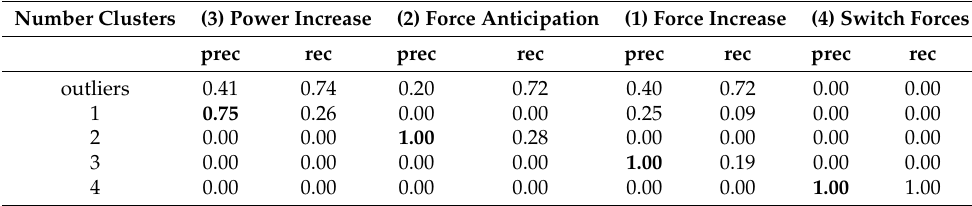
Table 5. Clustering results using OPTICS algorithm configured with the hyperparameter of minimum number of samples equal to 80, evaluated with precision (prec) and recall (rec)